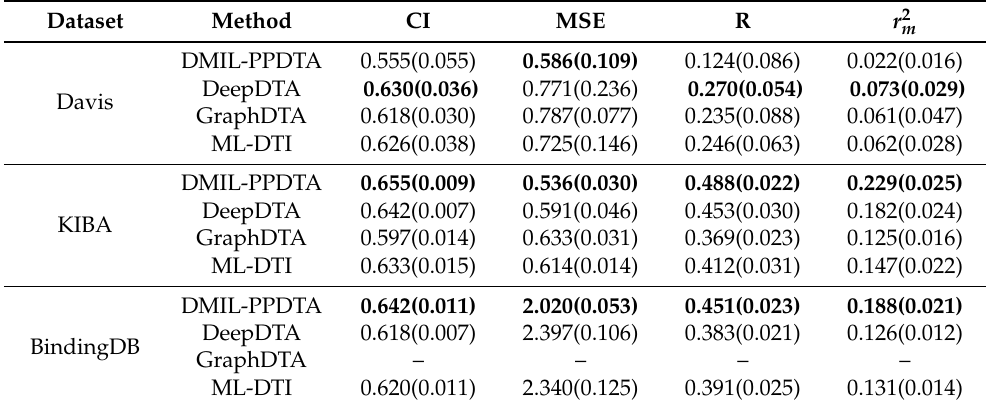
Table 3. Comparison among the results produced by our DMIL-PPDTA approach and the baseline approaches across the datasets under the blind setting. The entries in boldface denote the best result for each metric, and the data in brackets represent standard